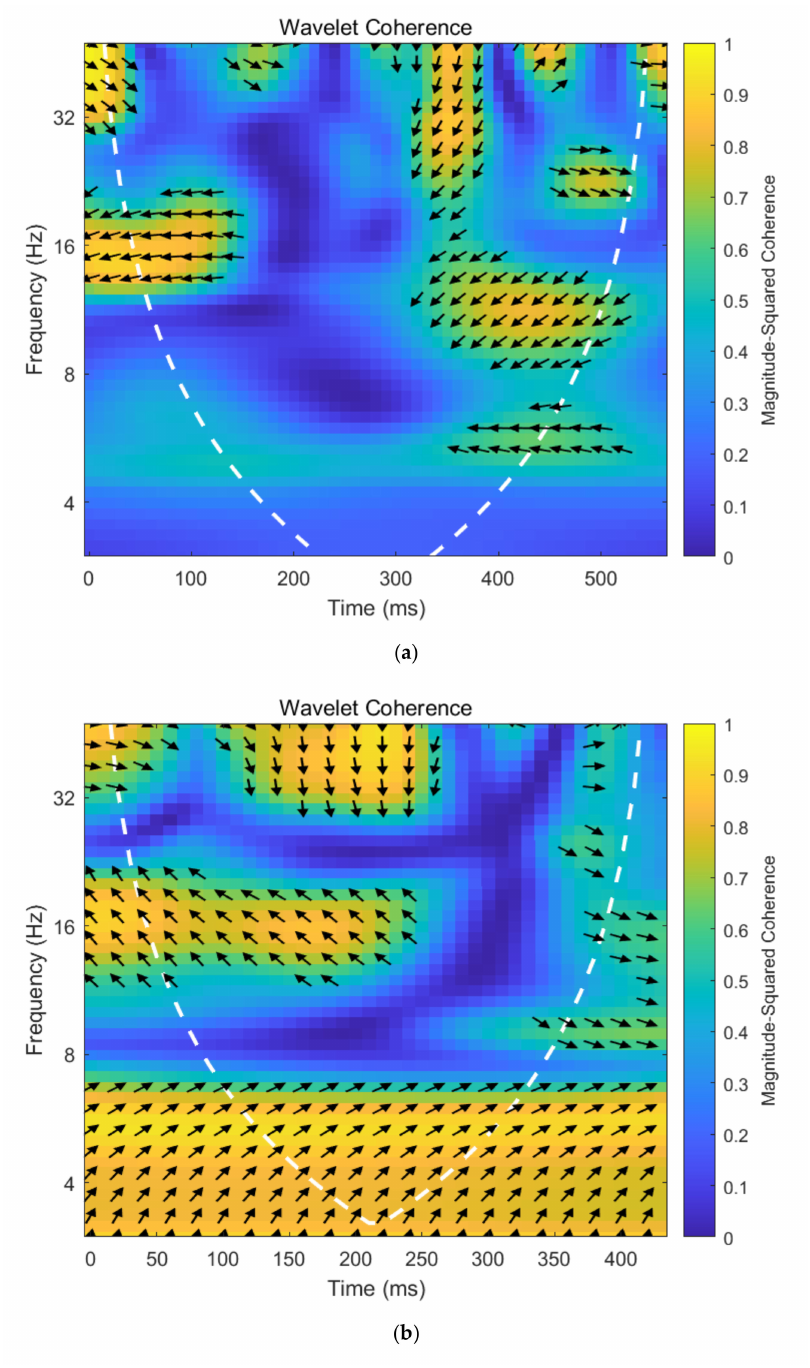
Figure 5. The wavelet coherency map between crude oil prices and investor sentiment under different trends of crude oil price. ( a ) exhibits the wavelet coherency map of crude oil prices and investor sentiment under rising trend in crude oil prices, while ( b ) presents the wavelet coherency map of crude oil prices and investor sentiment under down trend in crude oil prices. The color of a region from blue to yellow in a wavelet coherency map implies the coherence correlation between crude oil prices and investor sentiment become greater. The arrows show the correlation and lead lag relationship between crude oil prices and investor